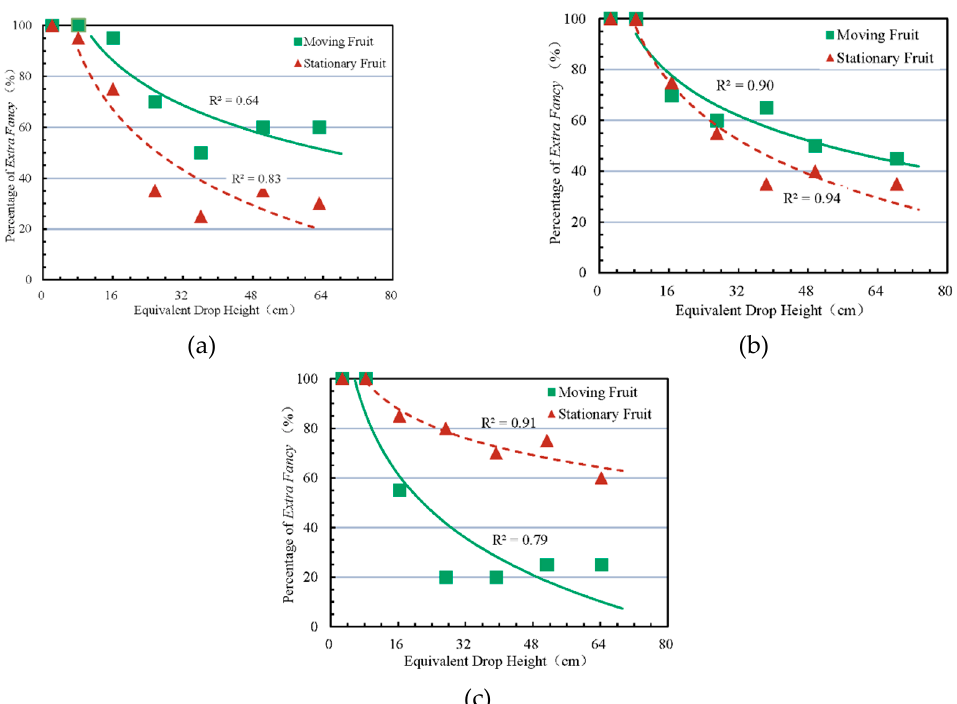
Figure 4. Percentages of Extra Fancy Class 1 grade fruit with increasing equivalent drop height for free apple-to-apple impact in ( a ) middle-to-top, ( b ) middle-to-middle, and ( c ) middle-to-bottom impact patterns. Logarithmic curves were fitted separately for stationary and moving fruit samples.